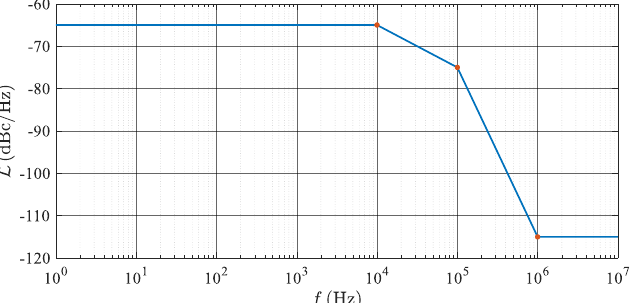
Figure 7. Phase noise spectral density L ( f ) of a typical mmW LO source described as − 65 dBc / Hz@10 kHz, − 75 dBc / Hz@100 kHz and − 115 dBc / Hz@1 MHz. The half-width of the phase noise pedestal is 10 5 Hz.